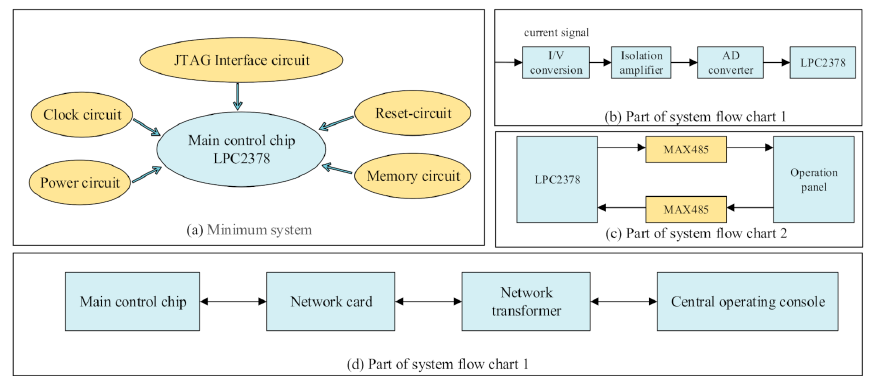
Figure 4. Composition of the MCU.